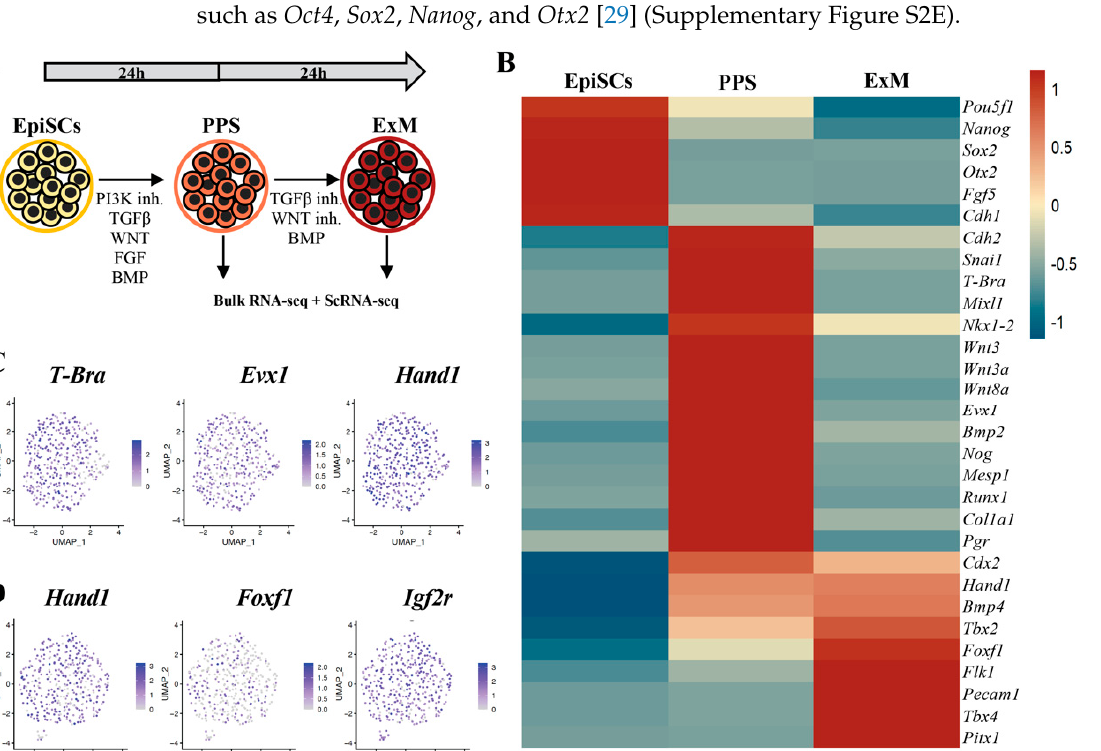
Figure 3. Pgr modulates PPS induction and extraembryonic mesoderm (ExM) formation. ( A ) Sche- matic illustration of the extraembryonic differentiation protocol. EpiSCs are initially subjected to PPS induction, and thereafter exposed to BMP for additional 24 h to induce ExM differentiation.